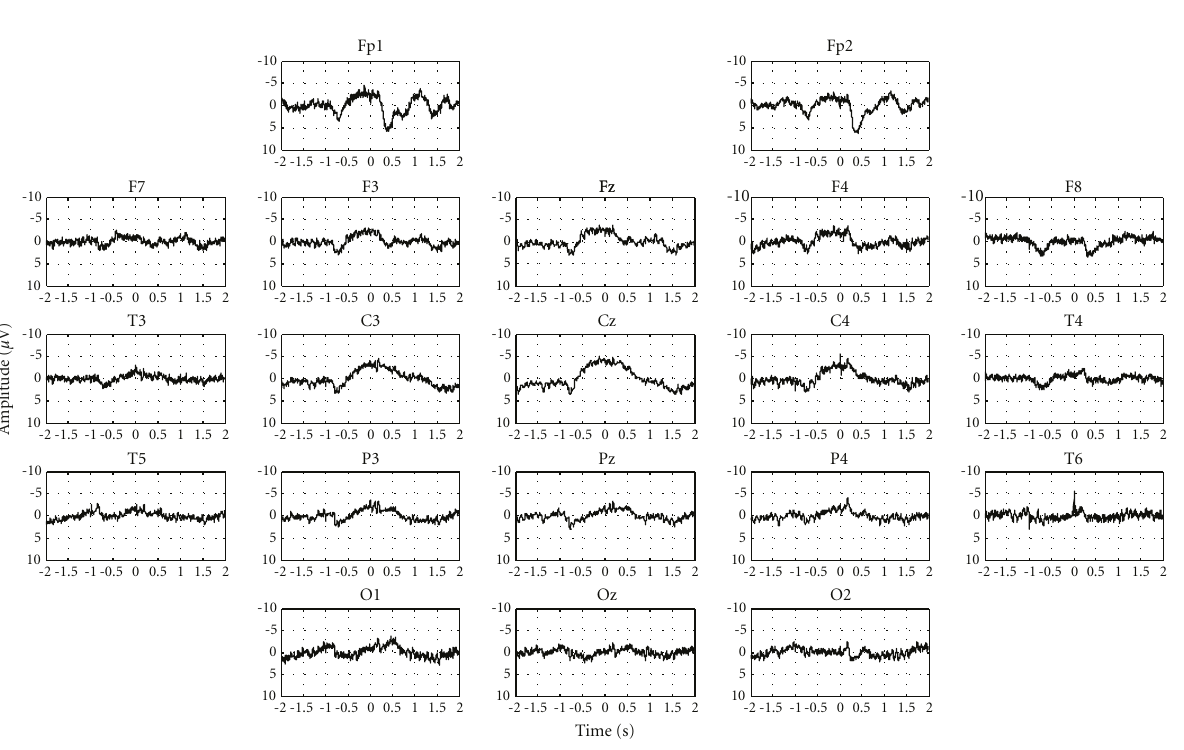
Figure 5: Grand Average topographic distribution of ERPs related to left index finger movement